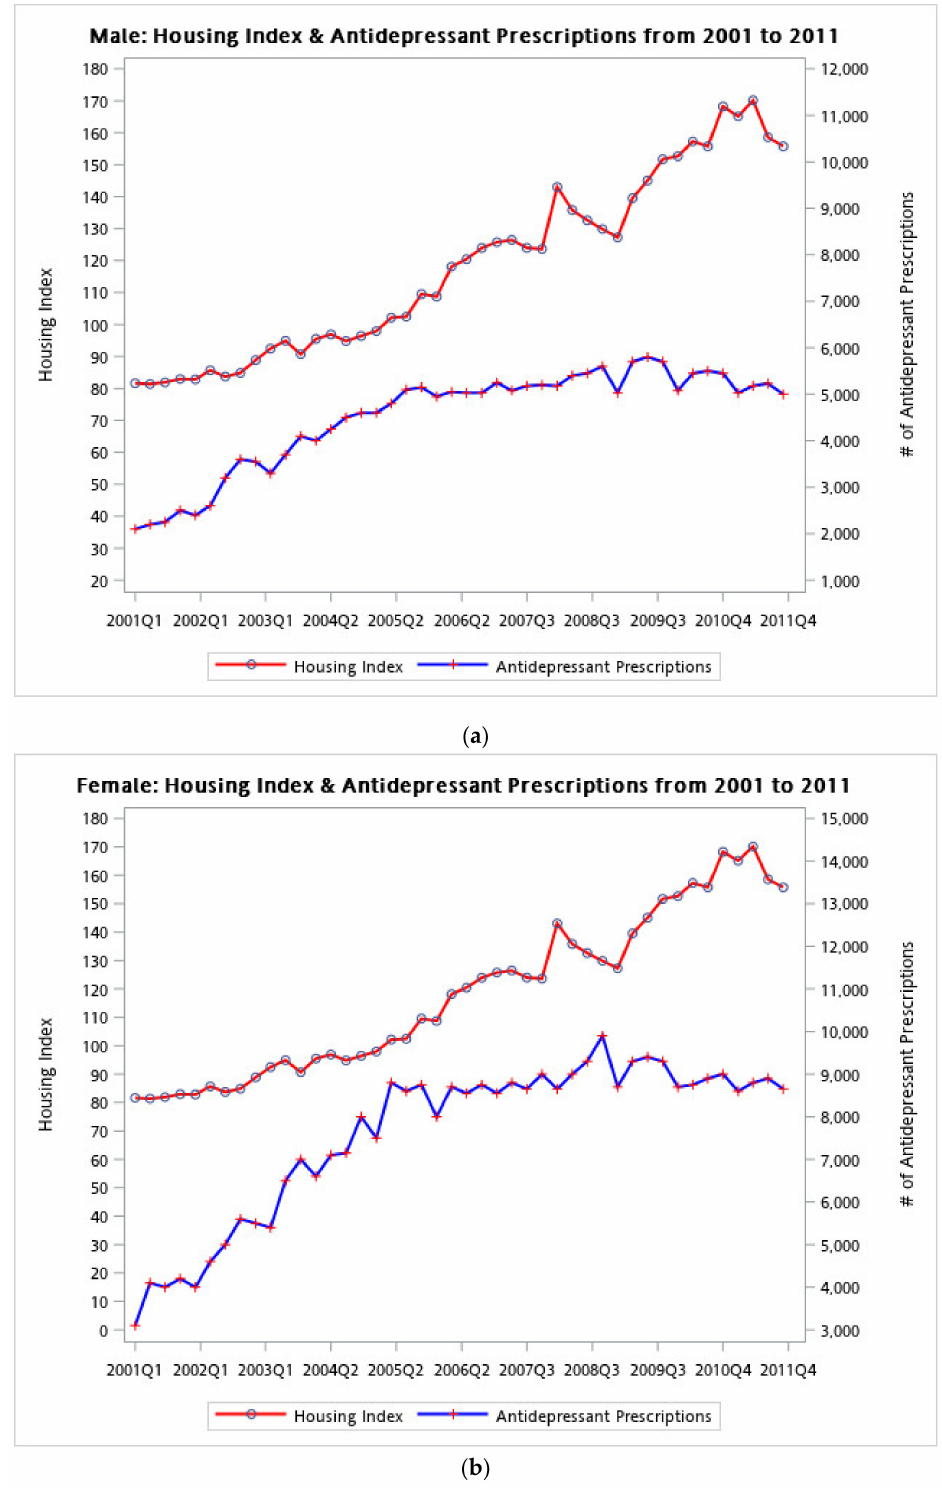
Figure 3. Line plot of housing indexes and antidepressant prescriptions stratified by sex. Housing indexes are presented as red dots, and antidepressant prescriptions are marked in blue. ( a ) Housing index and antidepressant prescriptions for male participants and ( b ) housing index and antidepres- sant prescriptions for female